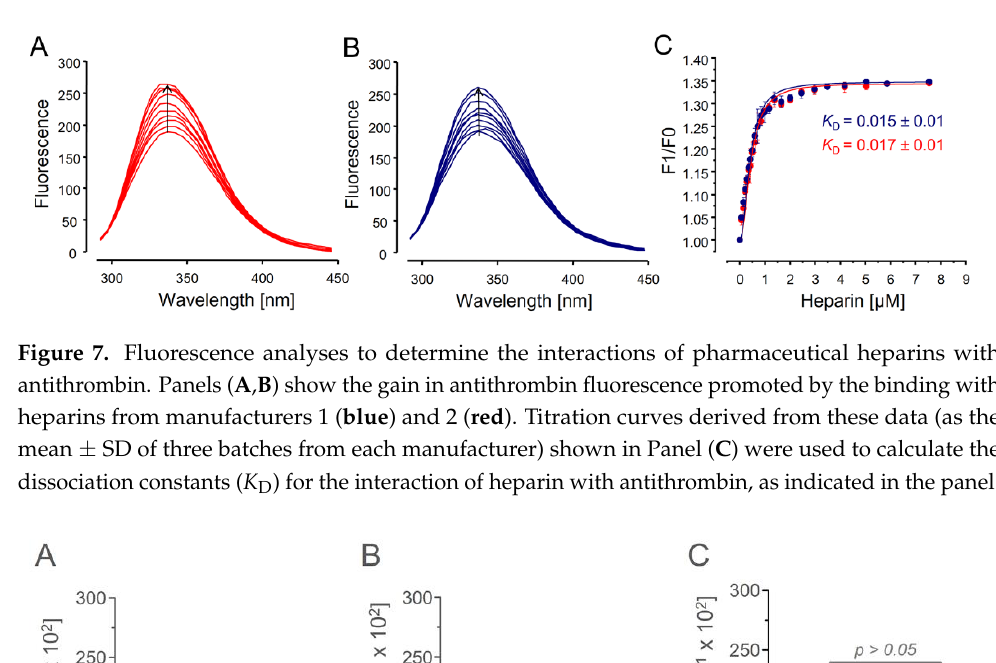
Figure 7. Fluorescence analyses to determine the interactions of pharmaceutical heparins with an- tithrombin. Panels ( A , B ) show the gain in antithrombin fluorescence promoted by the binding with heparins from manufacturers 1 (blue) and 2 ( red ). Titration curves derived from these data (as the mean ± SD of three batches from each manufacturer) shown in Panel ( C ) were used to calculate the dissociation constants ( K D ) for the interaction of heparin with antithrombin, as indicated in the panel.